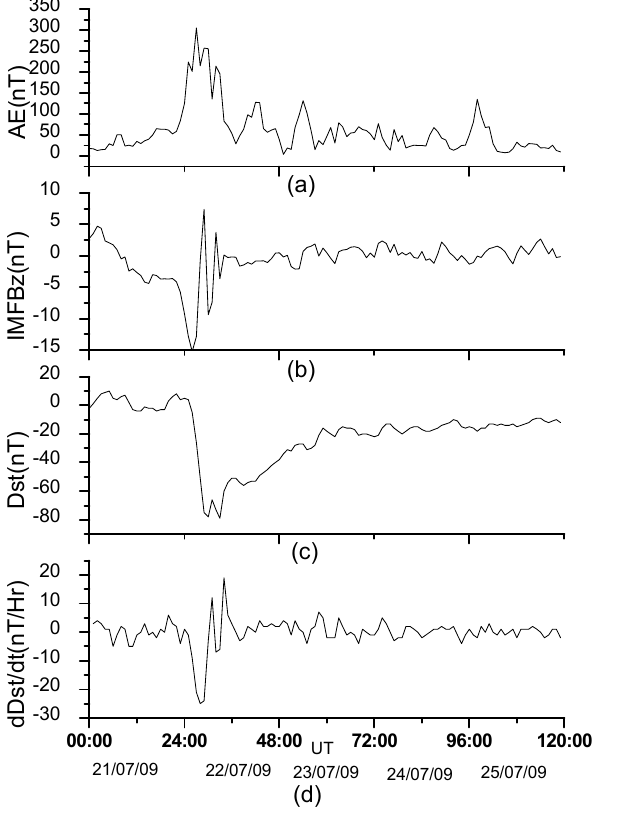
Fig. 10. The variation of AE, IMF B z , Dst, d Dst/ dt during 21– 25 July 2009.